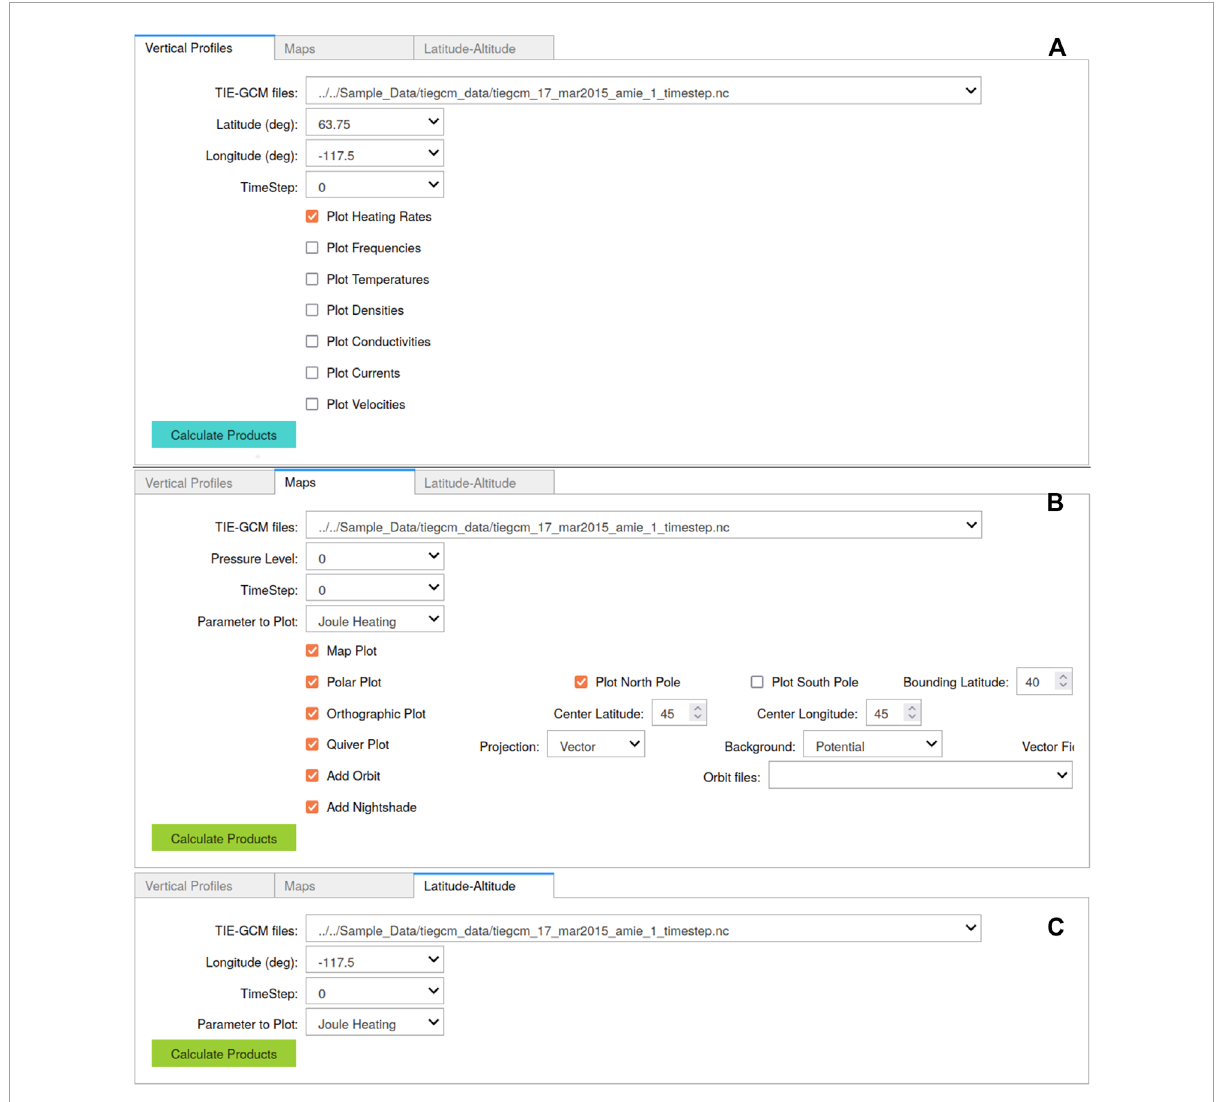
FIGURE 2 Graphical User Interface (GUI) for calculating and plotting: (A) vertical (altitude) profiles of various primary and derived products in TIEGCM; (B) derived products in TIEGCM as a function of latitude-longitude maps; and (C) latitude-altitude profiles of derived products in TIEGCM.